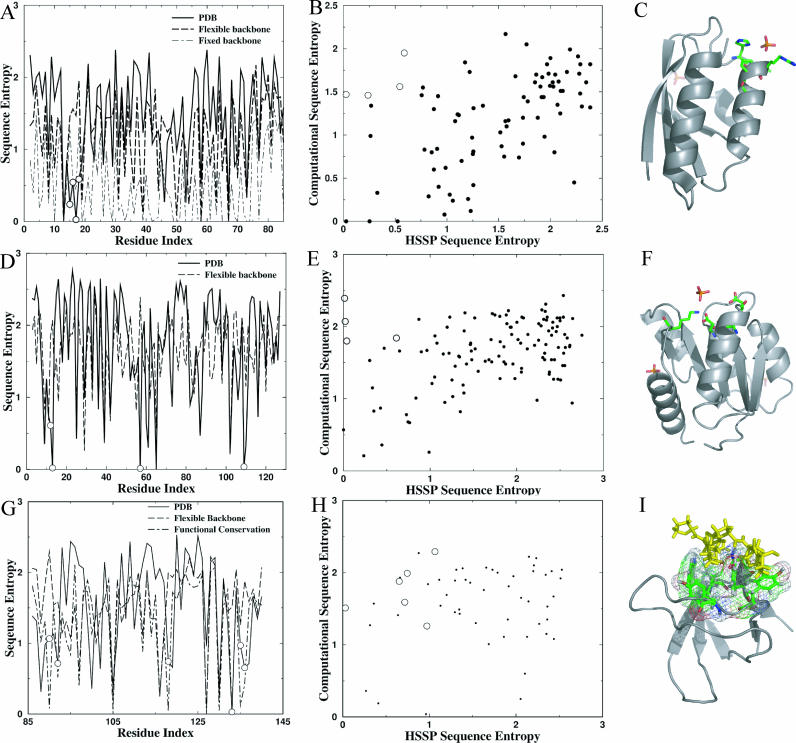
The Sequence Entropy Computed from Simulations versus the Naturally Occurring Sequence Entropy Computed from HSSPThree families of protein homologs were studied: HPR domain (A,D,G), ROSSMAN fold (B,E,H), and SH3 domain (C,F,I). The open circles (○) in (A–F) correspond to the functionally important residues. In (G–I), these functionally important residues are shown in stick representation. In (G,H), the SO4
2− ions are used to mimic the phosphate anion in crystal preparation. In (I), the poly-proline peptide are shown in yellow and the peptide-binding residues form a continuous surface, shown in mesh representation.